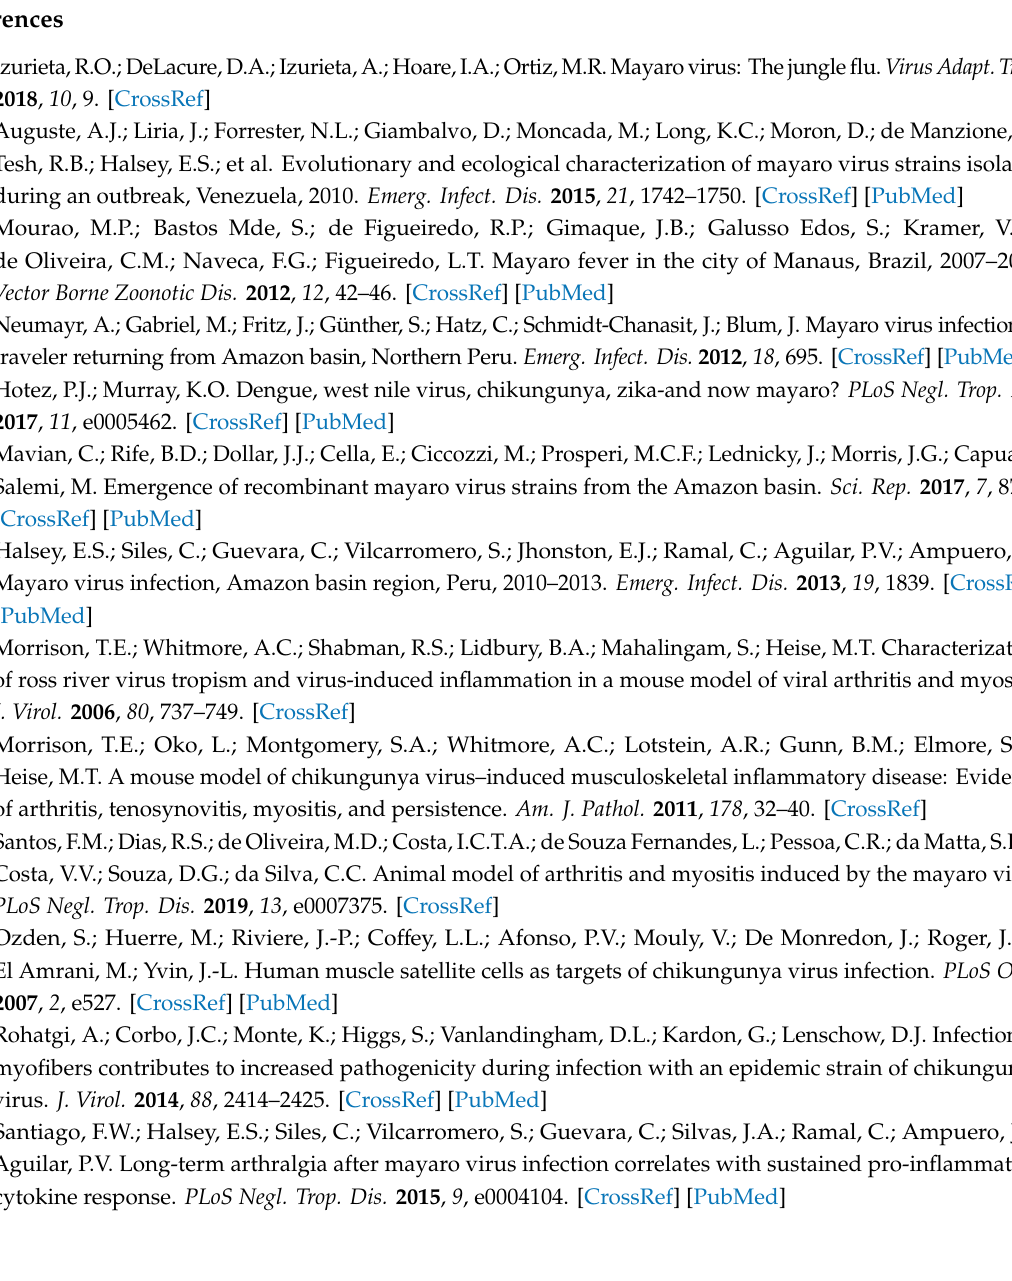
Figure S1: Mayaro virus induces upregulation of extracellular matrix breakdown genes, Figure S2: Expression of Viperin and MMP proteins following MAYV infection of primary human chondrocytes, Table S1. Primers used in this study, Table S2. Modulation of extracellular matrix genes by MAYV in primary human